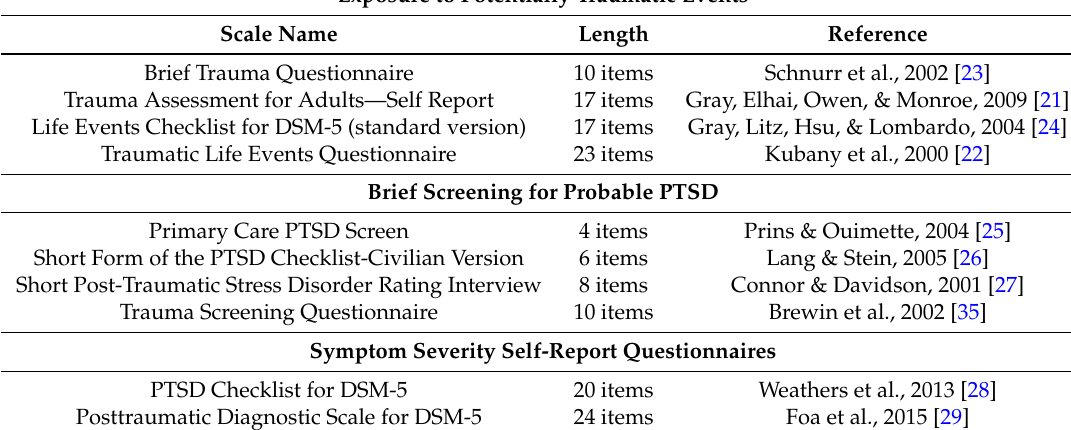
Table 1. Commonly used screening and self-report measures for trauma exposure and PTSD symptom